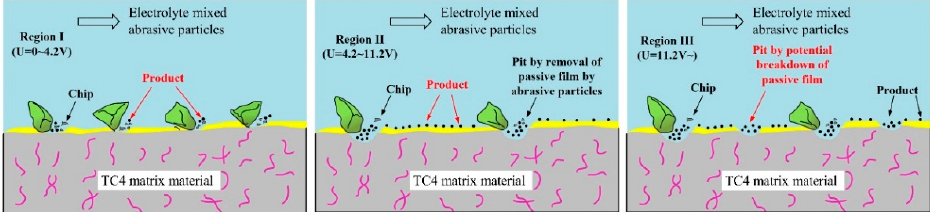
Figure 19. Models of material removal by ECFAP in different voltage